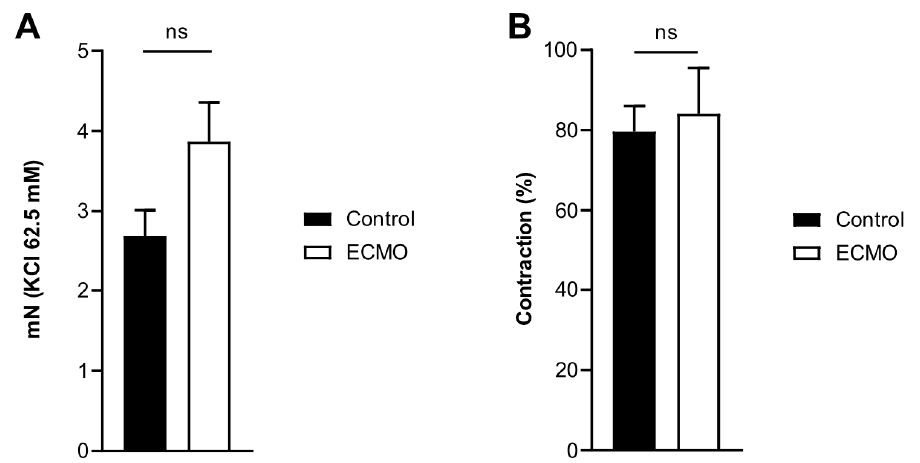
Figure 3. Contraction of porcine coronary arteries showed no difference between control and ECMO groups. Active wall tension induced by KCl 62.5 mM (panel A ) and U46619 (1 μ M; panel B ) in control ( n = 5) and ECMO ( n = 5) groups. No significant difference was found between the two groups (panel A , Control: mean = 2.67, S.E.M. = 0.34; ECMO: mean = 3.87, S.E.M. = 0.49; Student’s t -